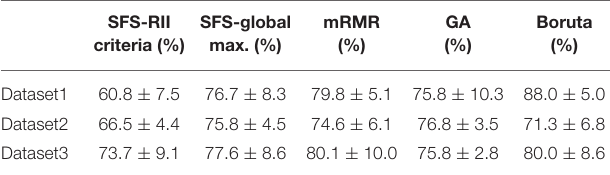
TABLE 5 | Classification accuracies obtained using half of the